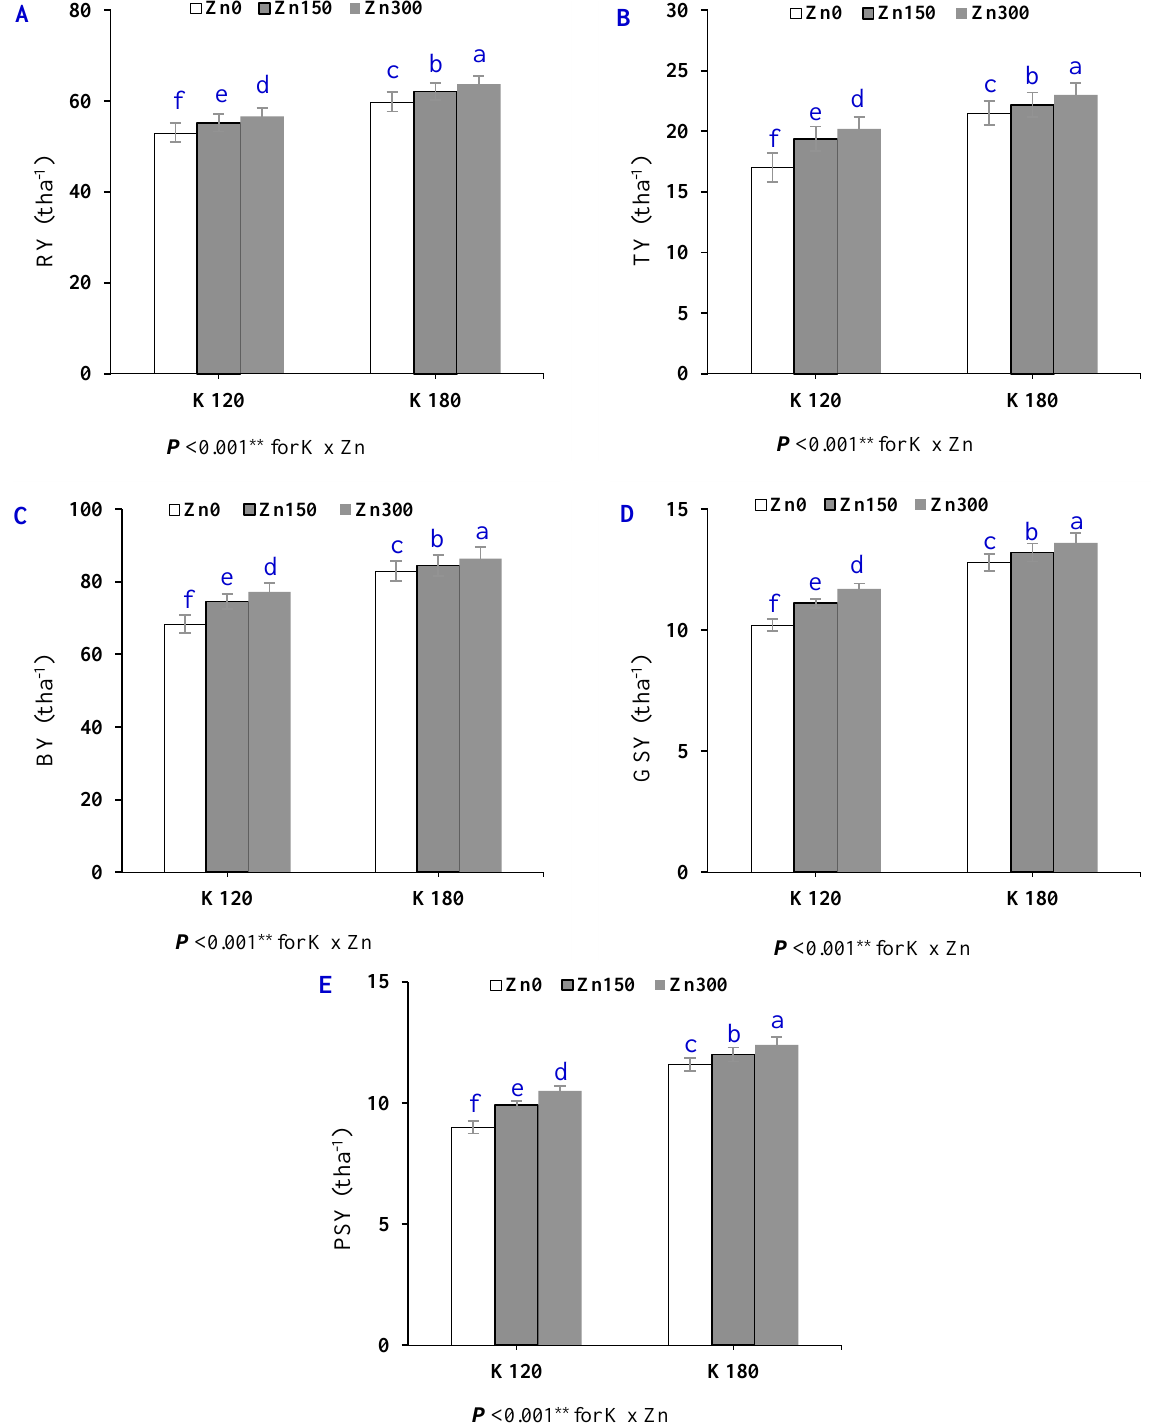
Figure 1. Interactive effect of two K rates (K = 120 (K 120 ) and 180 (K 180 ) kg ha − 1 ) and three foliar-applied Zn (0 (Zn 0 ), 150 (Zn 150 ) and 300 (Zn 300 ) ppm) on root yield (RY; A ), top yield (TY; B ), biological yield (BY; C ), gross sugar yield (GSY; D ), and pure sugar yield (PSY; E ) of sugar beet grown under saline soil (EC e = 8.60 dS m − 1 ) conditions. Bars sharing the same letter in each chart are not significantly ( p ≤ 0.05) different according to Duncan’s test. ** refer to significant difference at p ≤ 0.01.